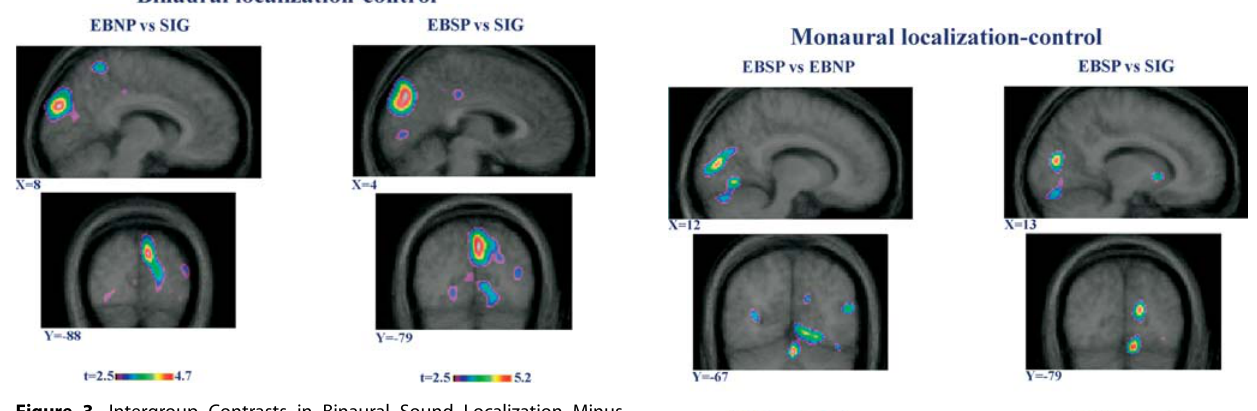
Figure 3. Intergroup Contrasts in Binaural Sound Localization Minus Control Task Sagittal (top) and coronal (bottom) images showing the contrasts between EBNP (left) compared to SIG, and EBSP (right) compared to SIG. These contrasts confirmed the differences in occipital areas between the SIG and the two other groups, which are likely attributable to a decrease in CBF activity in the sighted relative to the control task (see Figure 2). X and Y coordinates refer to standardized stereotaxic space. DOI: 10.1371/journal.pbio.0030027.g003 PLoS Biology |